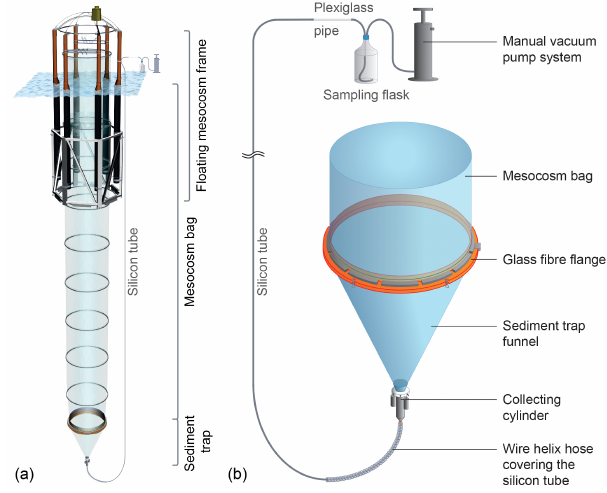
Figure 1. Panel (a) : technical drawing of the KOSMOS flotation frame with unfolded TPU enclosure bag and attached funnel-shaped sediment trap. Panel (b) : a silicon tube connects the collecting cylin- der at the tip of the sediment trap with a 5L sampling flask. A wire- reinforced hose prevents current-related bending of the first 1.5m. Particles can be easily detected in the Plexiglass ® pipe linking the silicon tube with the sampling